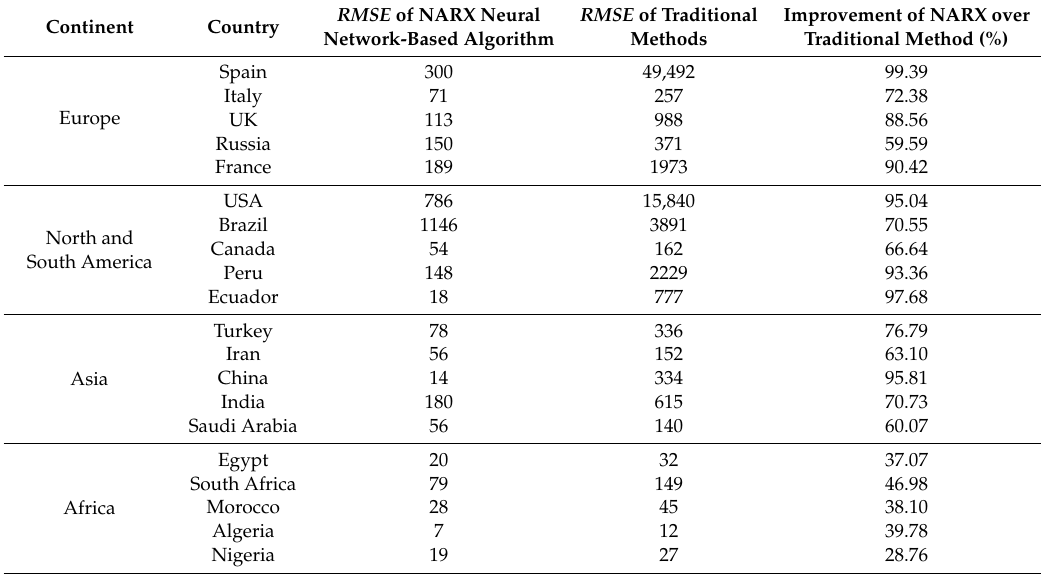
Table 5. Comparison of the results obtained from the NARX neural network-based algorithm and traditional methods. RMSE of NARX Neural RMSE of Traditional Improvement of NARX over Continent Country Network-Based Algorithm Methods Traditional Method (%) Spain 300 Europe